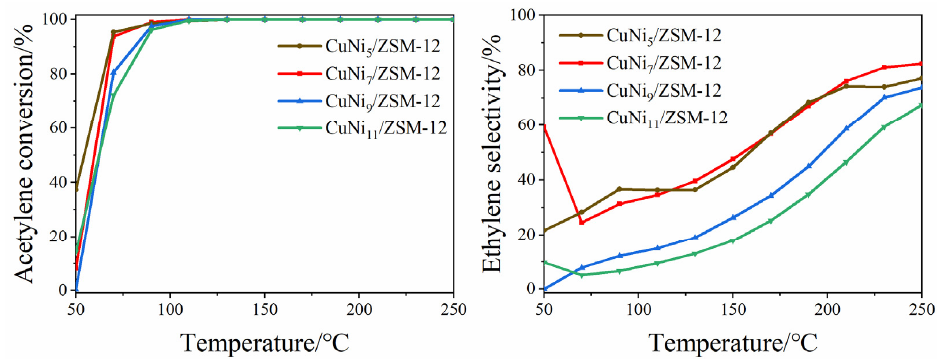
Figure 8. Activity test results of catalyst CuNi x /ZSM-12 (x = 5, 7, 9, 11).